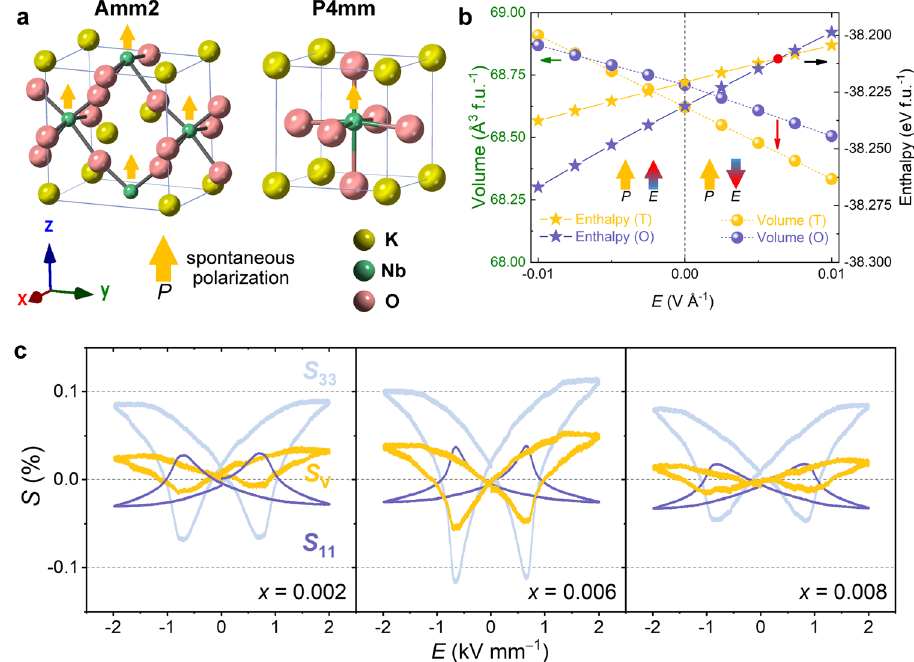
Fig. 4 DFT calculations and experimental volume changes. a Schematic of the applied fi nite electric fi elds in the DFT calculations. b Field dependence of the primitive cell volumes and enthalpies of the tetragonal and orthorhombic phases of KNbO 3 . The red dot marks the point where the enthalpies of the tetragonal and orthorhombic phases are equal. The red arrow indicates the volume shrinkage for a phase transition from the O phase to the T phase. c Experimentally measured macroscopic volume change as a function of the electric fi eld. Simultaneously recorded longitudinal ( S 33 ) and transverse ( S 11 ) strains and calculated volume strain of the compositions x = 0.002, x = 0.006, and x =